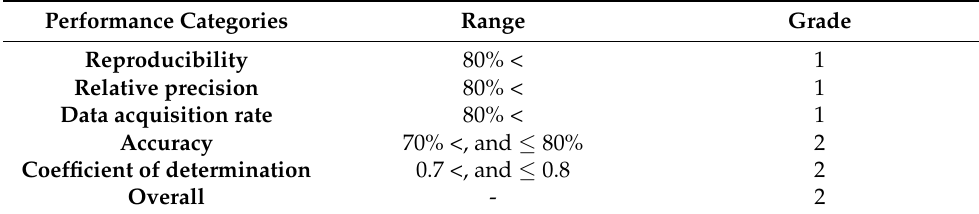
Table 4. Certified performance grade of CPMS.